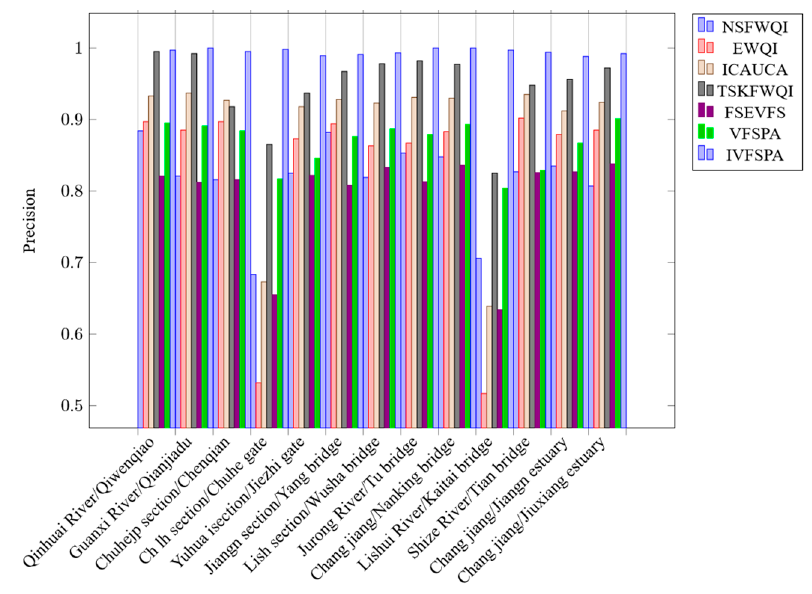
Figure 6. Precision values.